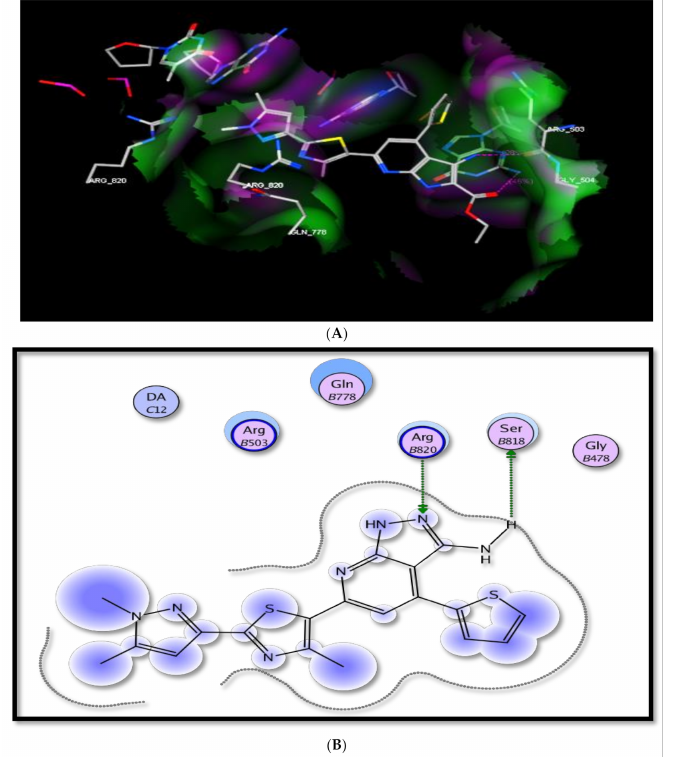
Figure 9. The suggested binding mode of compound 12 within topoisomerase II. ( A ) 3D binding mode within the active site. ( B ) 2D binding mode within topoisomerase